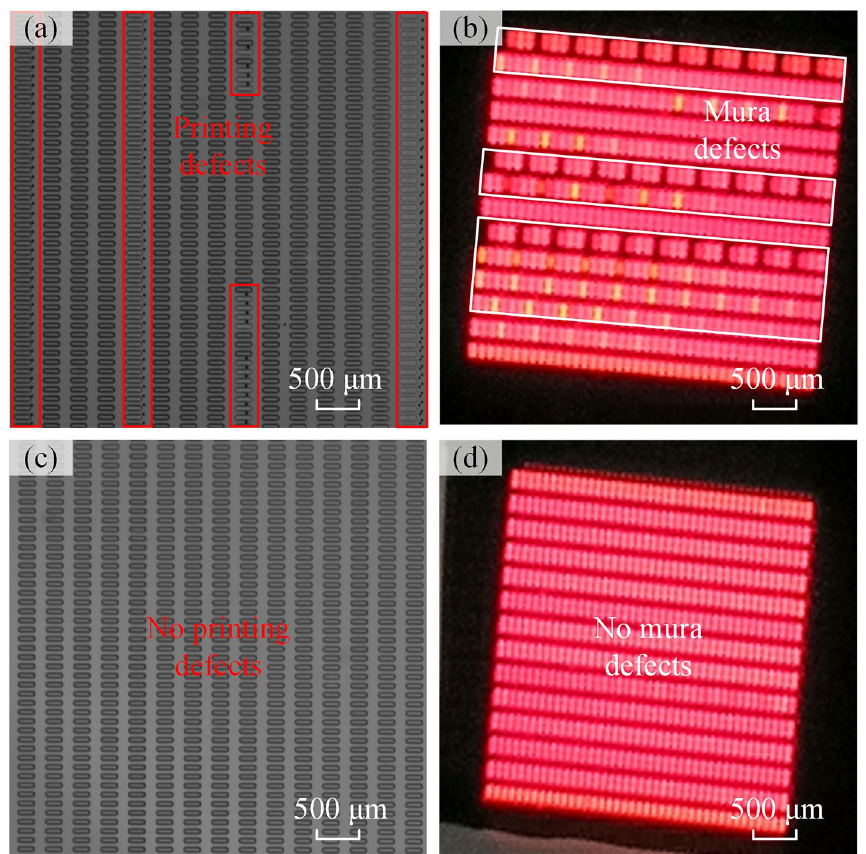
Figure 10. Printing and lighting results for panels with the traditional printing method and SCPP method. ( a ) The defective printing result from the traditional printing method. ( b ) Defective lighting resulting from the traditional printing method. ( c ) The defect-free printing result from the SCPP method. ( d ) The defect-free lighting result from the SCPP